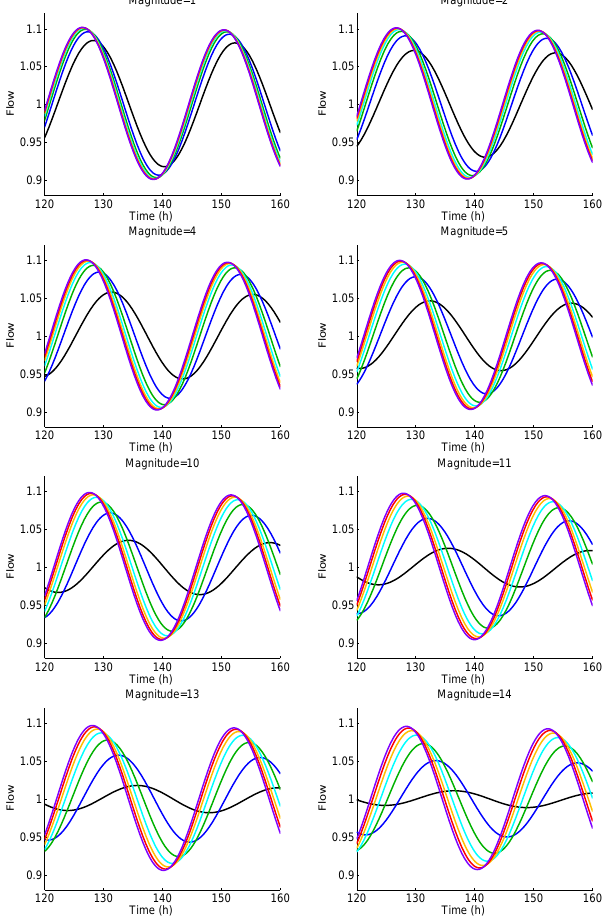
Figure 7. Flows at the outlet of each magnitude link using different k in each river simulation. The k values (with units of h − 1 ) are 0.38, 0.7, 1.02, 1.34, 1.66, 1.98, and 2.30 and are colored black, blue, green, cyan, orange, red, and purple, respectively. The flows are normalized about the average